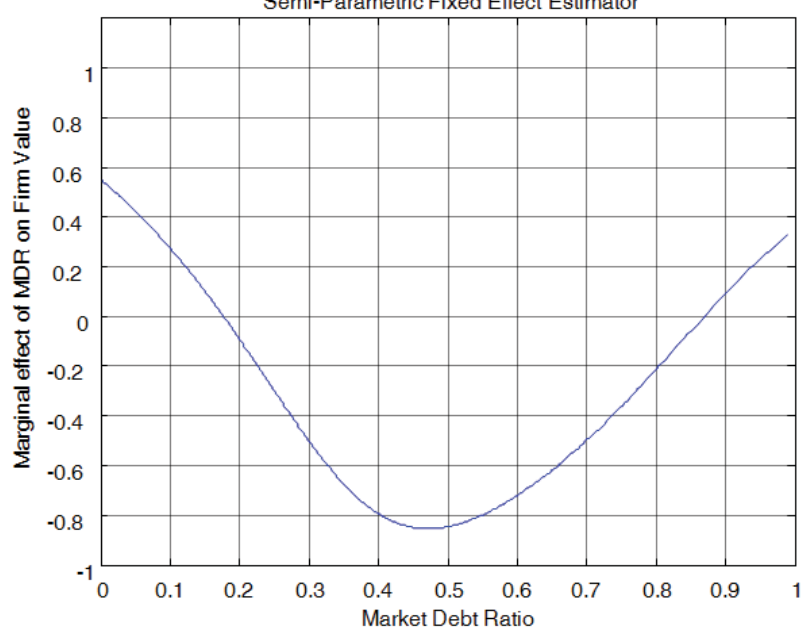
Fig. 3. Marginal effectof the MDR on FirmValue , as determined from the SFE model Table 3. SFE model for marginal effect